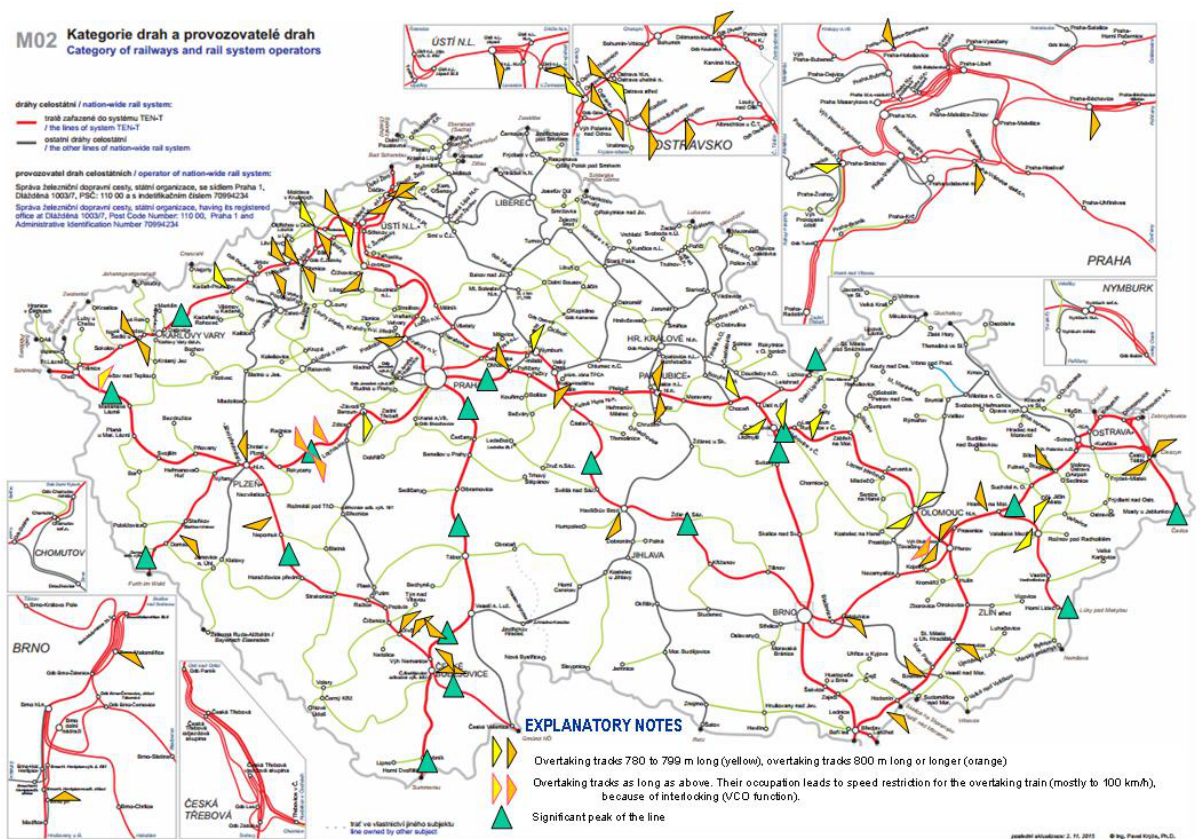
Figure 1. Presence of available long overtaking tracks in Czech TEN-T railway network. Map source: